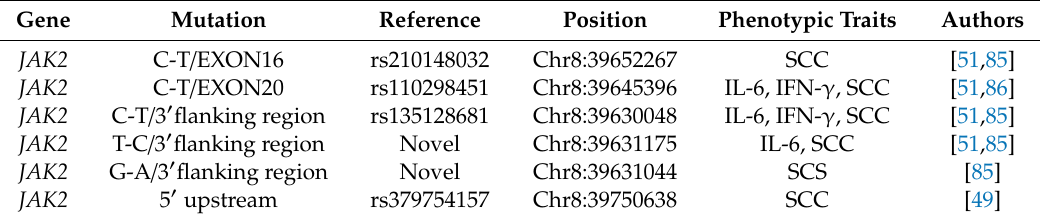
Table 1. Association of SNPs in JAK2 with bovine mastitis resistance phenotypic